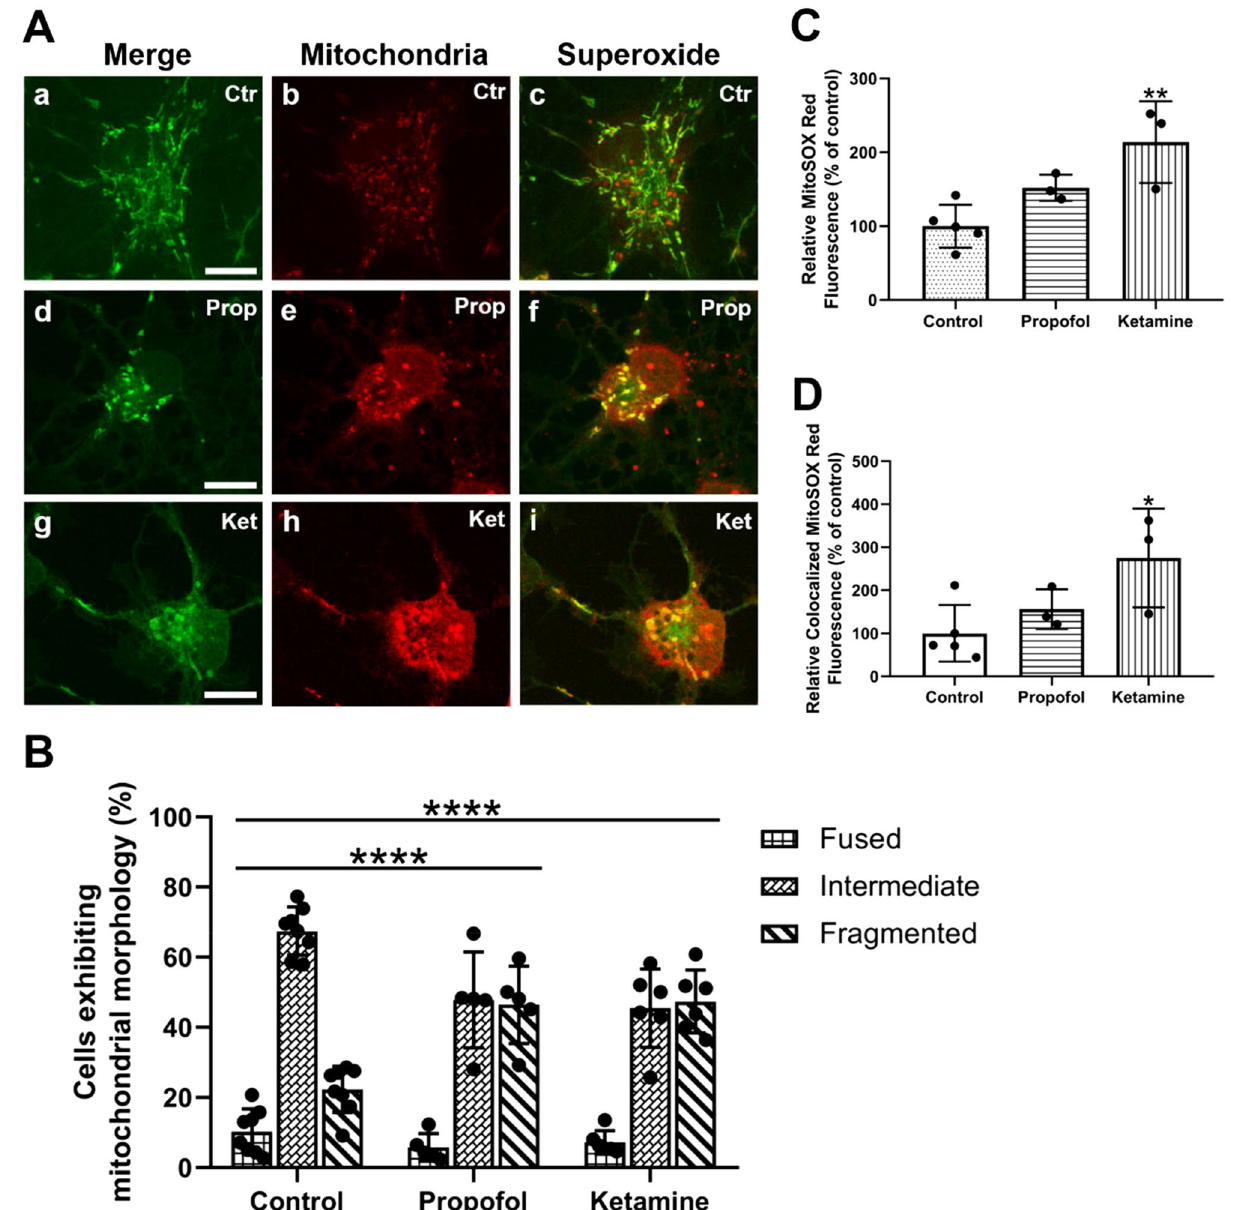
Figure 5. Propofol and ketamine induce mitochondrial fragmentation and ketamine dramatically increases SO production in primary cortical neurons. Representative cropped fluorescent images showing neurons from each condition which were co-stained with MitoTracker Green FM for mitochondria and the mitochondrial SO indicator MitoSOX Red (A) . Quantification of predominant mitochondrial morphology in each treatment. Both propofol and ketamine caused an increase in the proportion of cells exhibiting fragmented mitochondrial networks (B) . Quantification of relative SO production (C) . Propofol-treated neurons did not significantly differ from control, whereas ketamine more than doubled relative SO production. Quantification of relative SO based on MitoSOX Red signal which colocalized to MitoTracker Green FM (D) . Propofol did not significantly impact mitochondrial SO production, while ketamine almost tripled mitochondrial SO production compared to control. One-way or two-way ANOVA. * p < 0.05, ** p < 0.01, **** p < 0.0001 as determined by pairwise comparison of post-hoc tests. Bars indicate ± SD across at least biological replicates. Each data-point indicates the either the percentage of cells that exhibited a specific morphology per dish, or the mean SO signal recorded per dish. Scale bars indicate 10